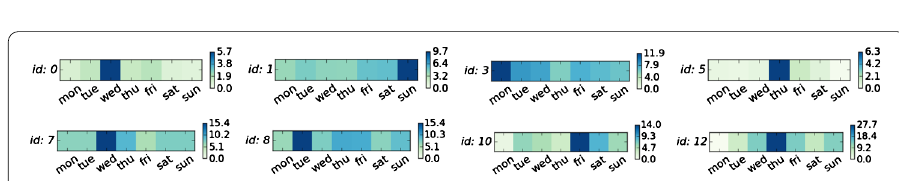
Figure 13 T-Mall collective temporal purchasing footprints. Selection of the 15 collective temporal purchasing footprints for T-Mall dataset depicted as heat-maps: the darker the color, the higher the number of items purchased. On the x axis are reported the days of the